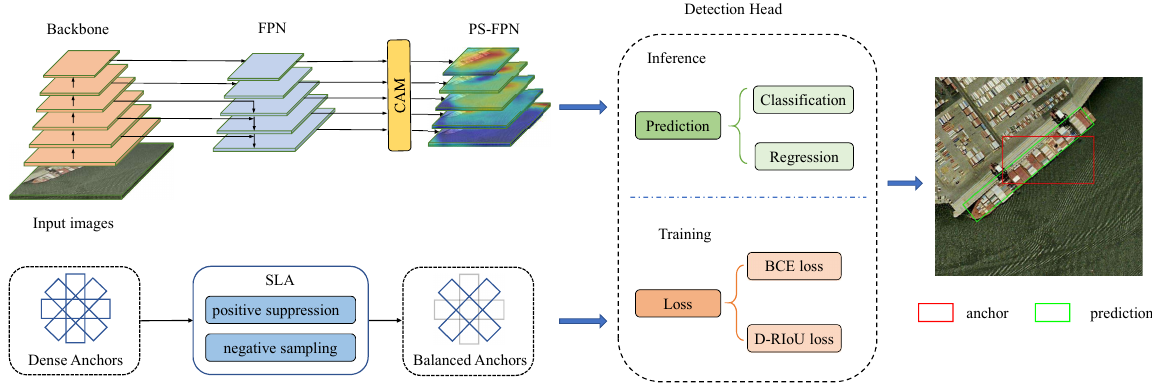
Figure 2. The overall framework of our